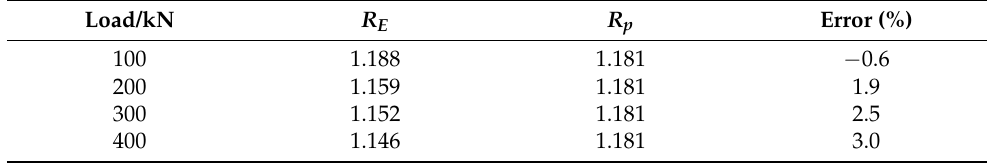
Table 2. λ max comparison in SU-WSCS.